Question: Write a descriptive caption for this figure.
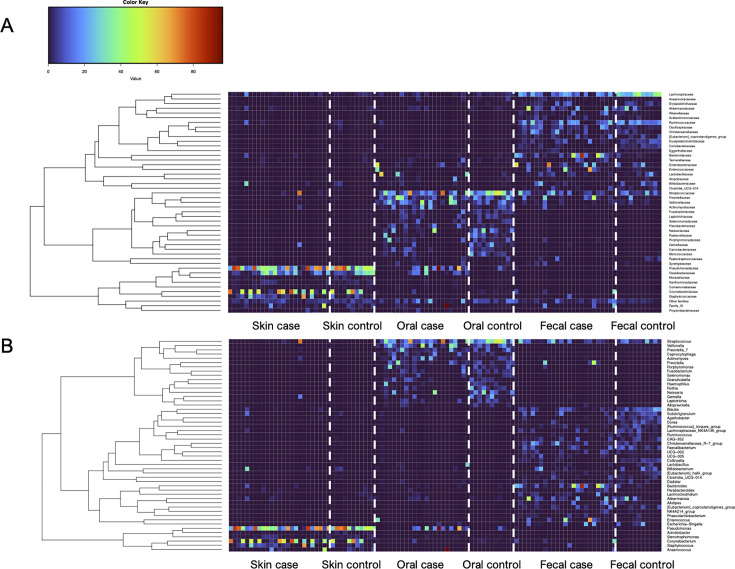
Answer: Oral, gut, and skin microbiota signatures of patients with heart valve disease with and without infective endocarditis. Heatmap showing Ward-linkage clustering based on Pearson’s correlation coefficients of the relative abundance of families ( A ) and genera ( B ) in the oral, gut, and skin microbiota of cases and controls. Only taxa with relative abundance ≥1% in at least 20% of samples for each study group are shown. Those with relative abundance <1% were grouped as “Other.” See also Fig. S1 and S2 .